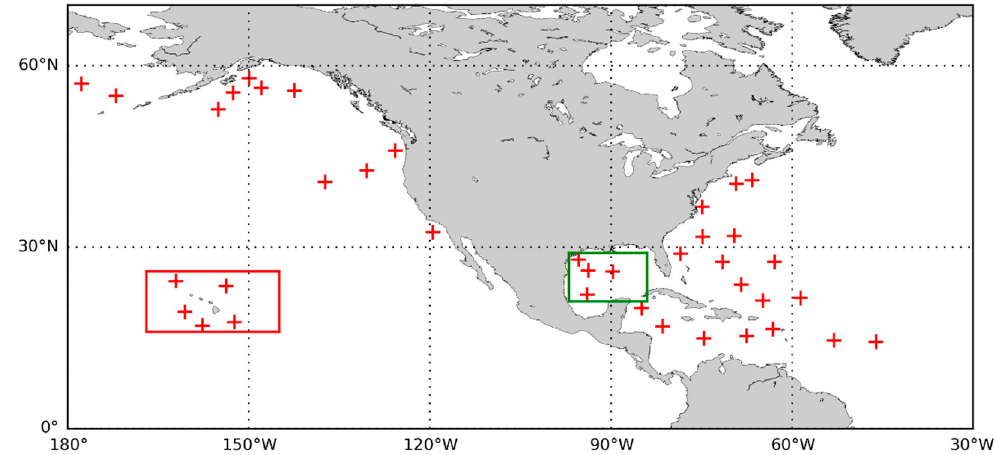
Figure 2. Locations of National Data Buoy Center (NDBC) buoys.